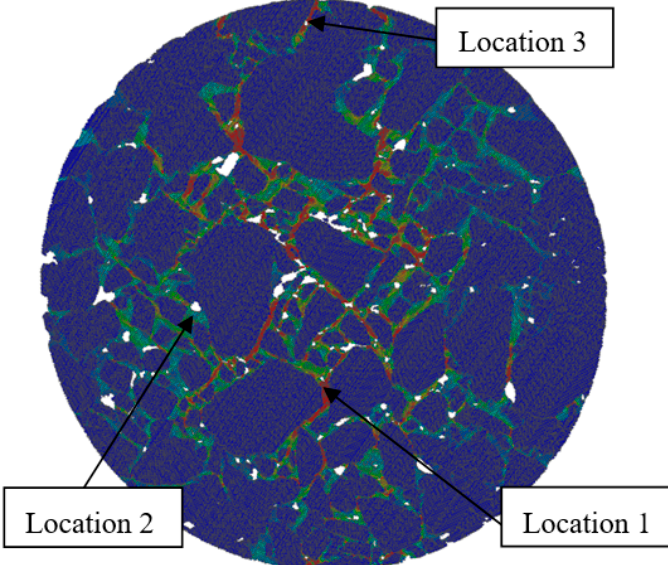
Figure 11. Selected locations for analysis from the digital sample.